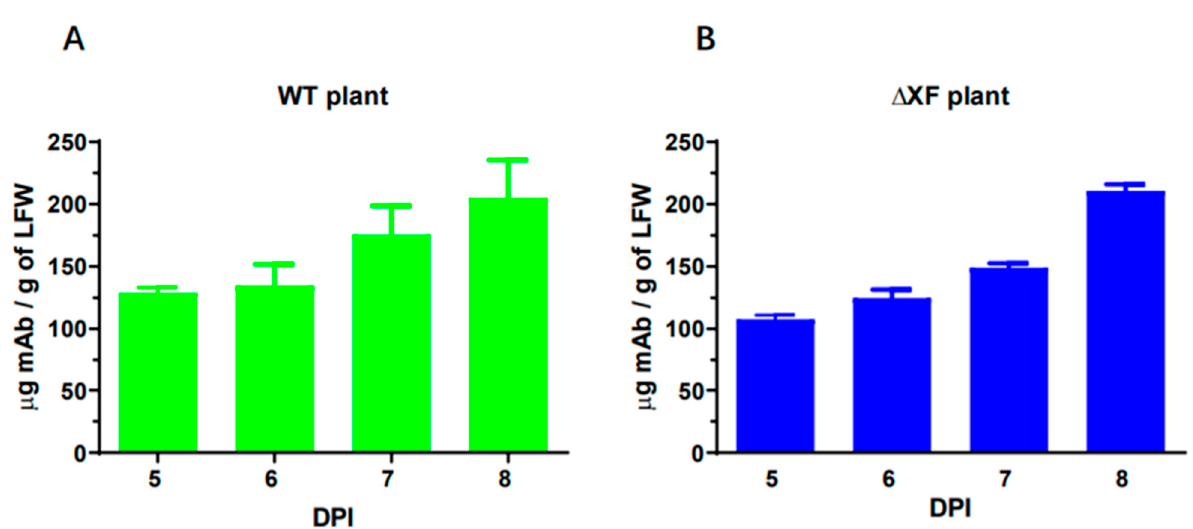
Figure 1. Temporal expression of ZV1 in N. benthamiana leaves. Leaves of WT ( A ) and ∆ XFT ( B ) N. benthamiana plants were agroinfiltrated with ZV1 light chain and heavy chain expression vectors, and total leaf proteins were extracted on 5–8 DPI. MAb accumulation levels were quantitated by an ELISA that detects only assembled forms of IgG. Mean ± standard deviation (SD) from three independent infiltrations with technical triplicates are presented.